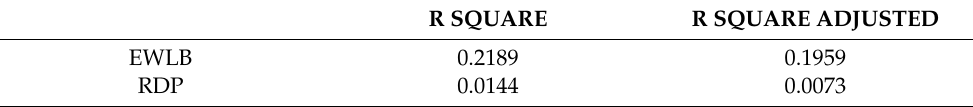
Table 7. R 2 matrix.